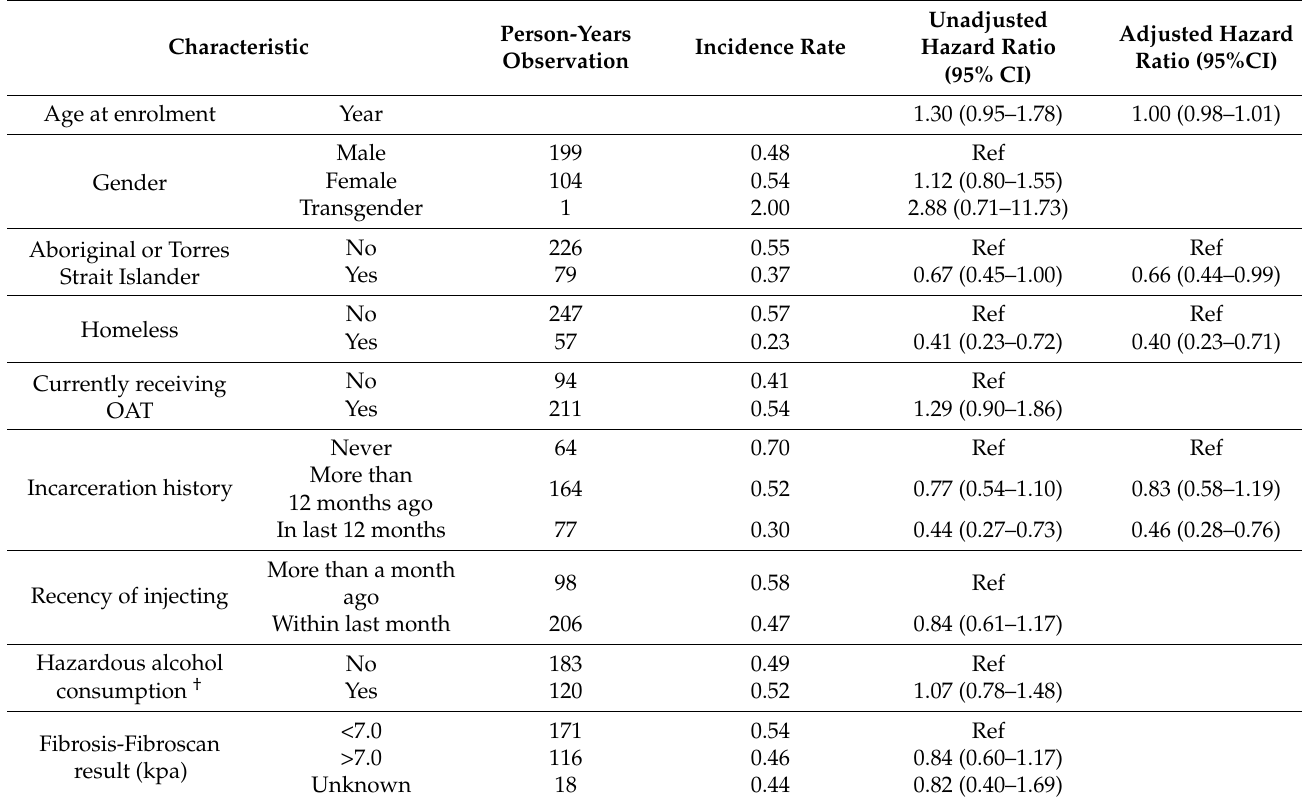
Table 2. Cox regression–factors associated with treatment initiation at 24 months post-diagnosis ( n =